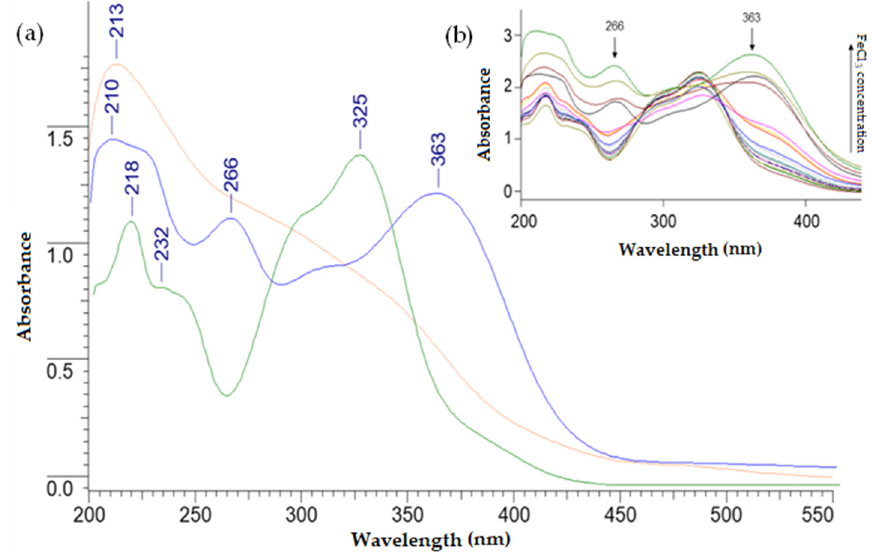
Figure 5. ( a ) UV/Vis spectra of FeCl 3 in tris-HCl buffer, with C = 10 − 4 M (red line), 5-CQA in tris-HCl buffer, with C = 10 − 4 M (green line), and iron(III) with 5-CQA complex in 1:1 molar ratio in tris-HCl buffer, with C = 10 − 4 M (blue line) recorded in the range of 200–550 nm. ( b ) The UV/Vis spectra of successive series of prepared solutions; the increasing concentration of FeCl 3 is